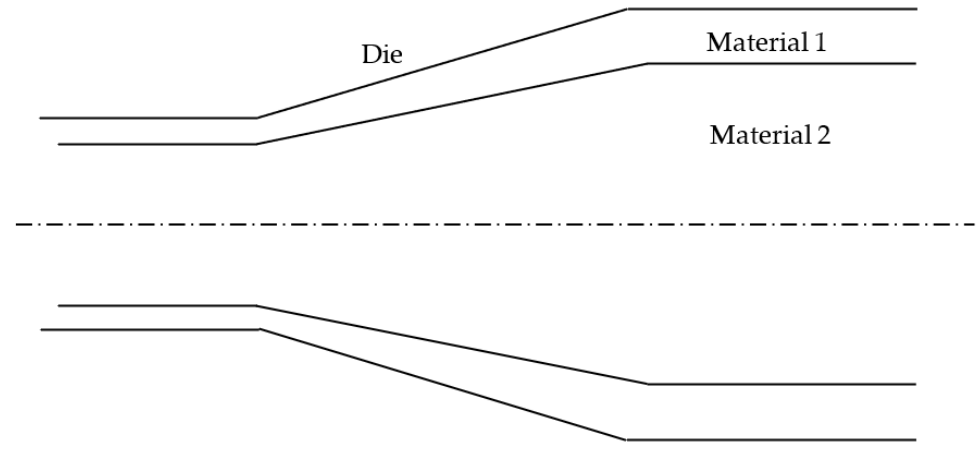
Figure 3. Schematic diagram of a bi-metallic extrusion process.